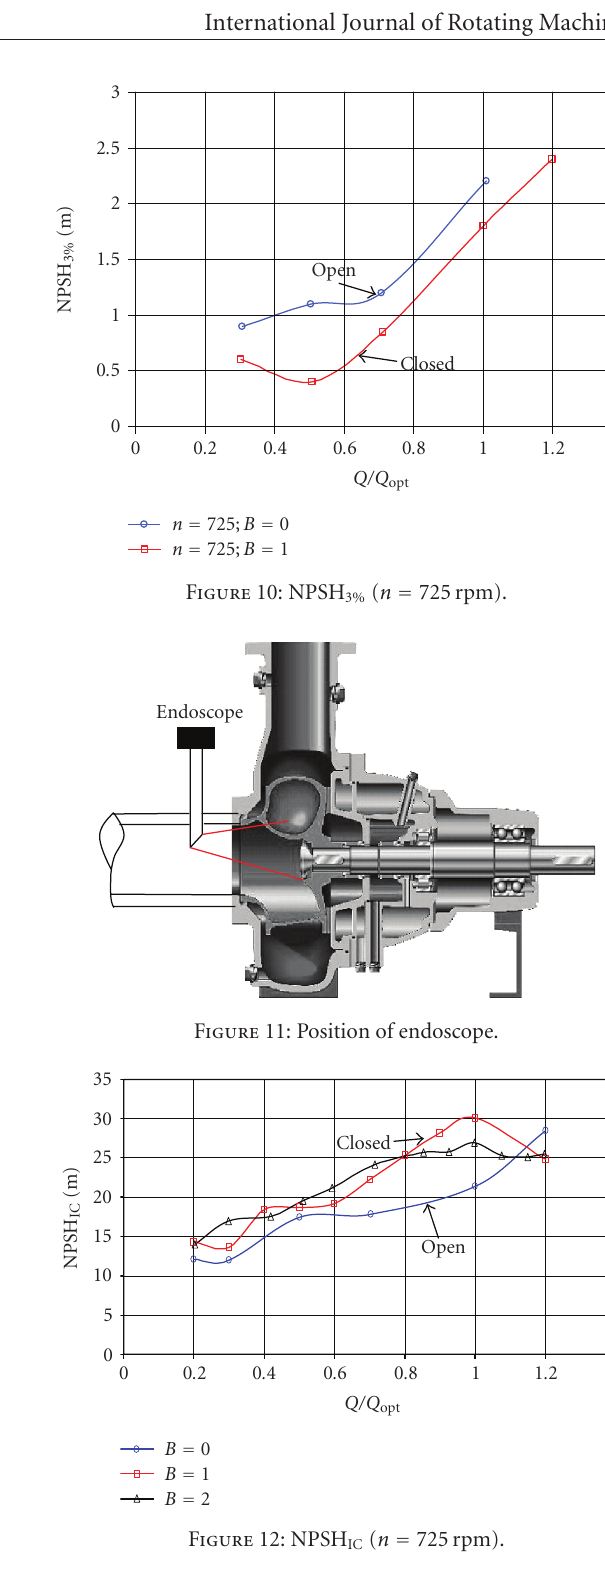
other hand, this creates a relatively large dead water zone just behind the leading edge due to flow separation. Cavitation typically locates in this area.